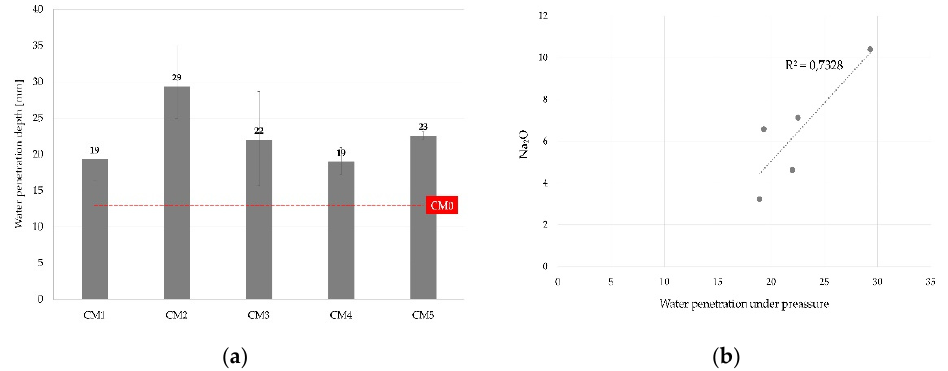
Figure 10. ( a ) Water penetration under pressure; ( b ) correlation between water penetration and alkali content in WBA samples.